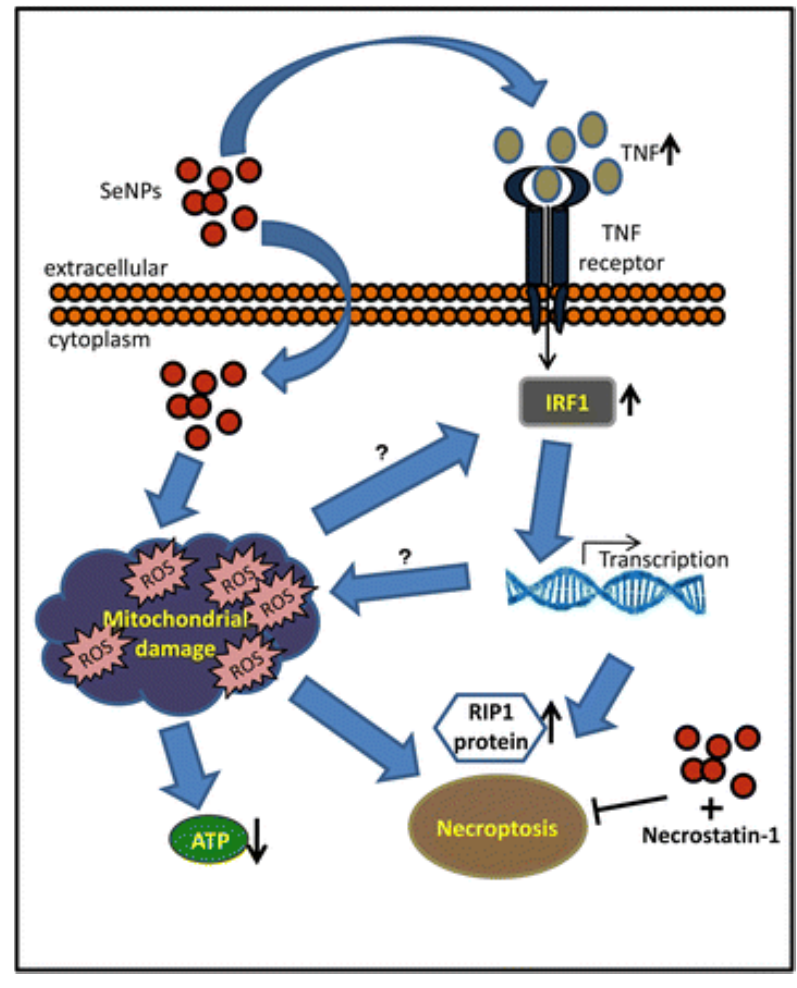
Figure 10. Anticancer effect of biogenic, spherical SeNPs, synthesized by a living culture of B. lichenisformis , against PC3 cells via a necroptosis pathway. Adapted with permission from Ref. [295] under the terms of the Creative Commons CC BY license. 2017, Springer